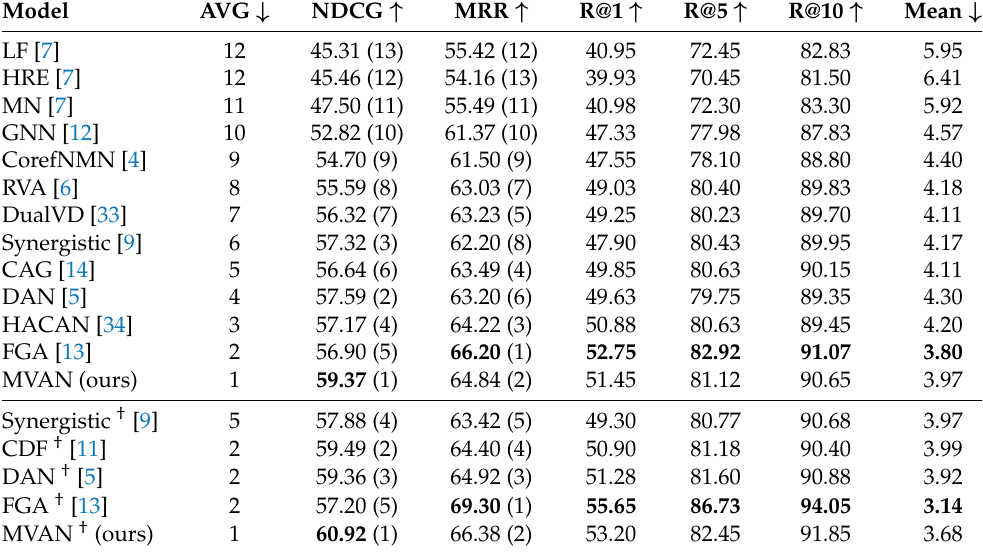
Table 1. ResultsonVisDialv1.0(test-std). † denotesensembles. Existingworks[17,18]basedonpre-trained models are not reported for the fair comparison. The numbers in the brackets indicate rankings of the models in Normalized Discounted Cumulative Gain (NDCG) and Mean Reciprocal Rank (MRR) metrics. Model AVG